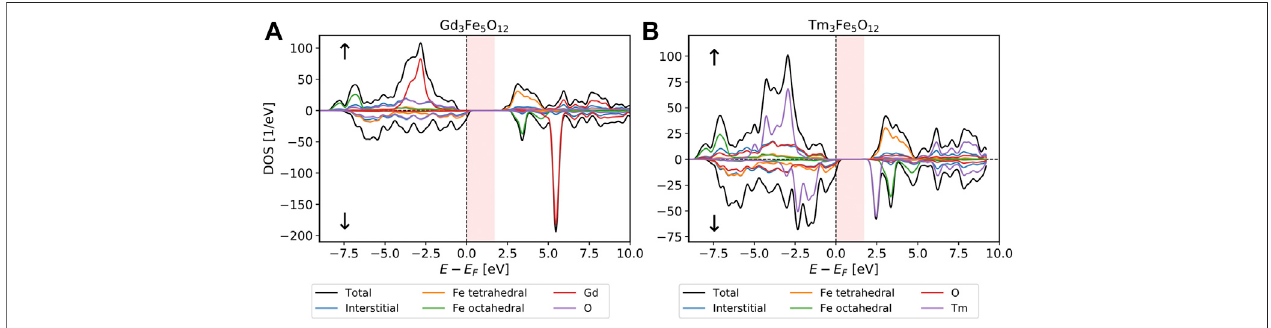
FIGURE 8 | The density-of-states is calculated for GdIG in (A) and for TmIG in (B) using PBE0 on a 2 × 2 × 2 k -point grid. Both calculations were performed with a K